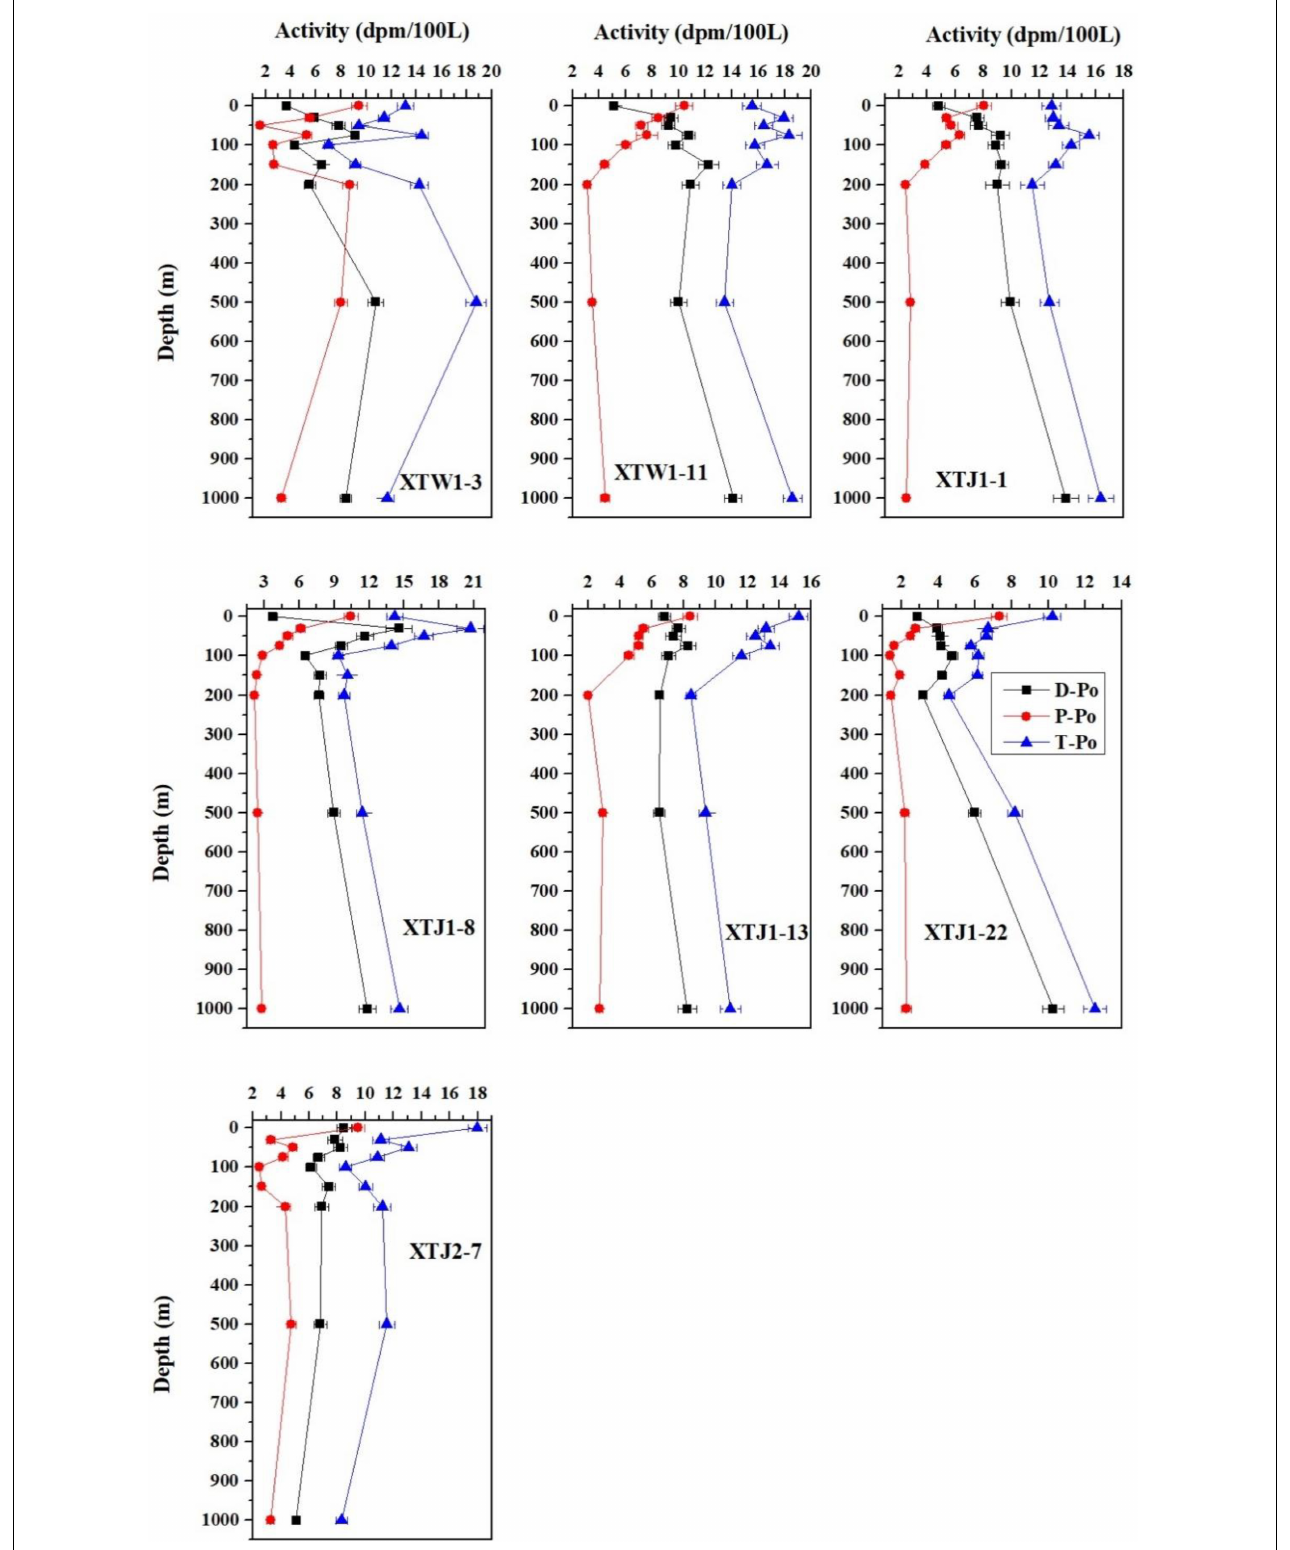
FIGURE 4 | Vertical distributions of particulate (P), dissolved (D), and total (T) 210 Po in the water column at each station in the w-NPO.